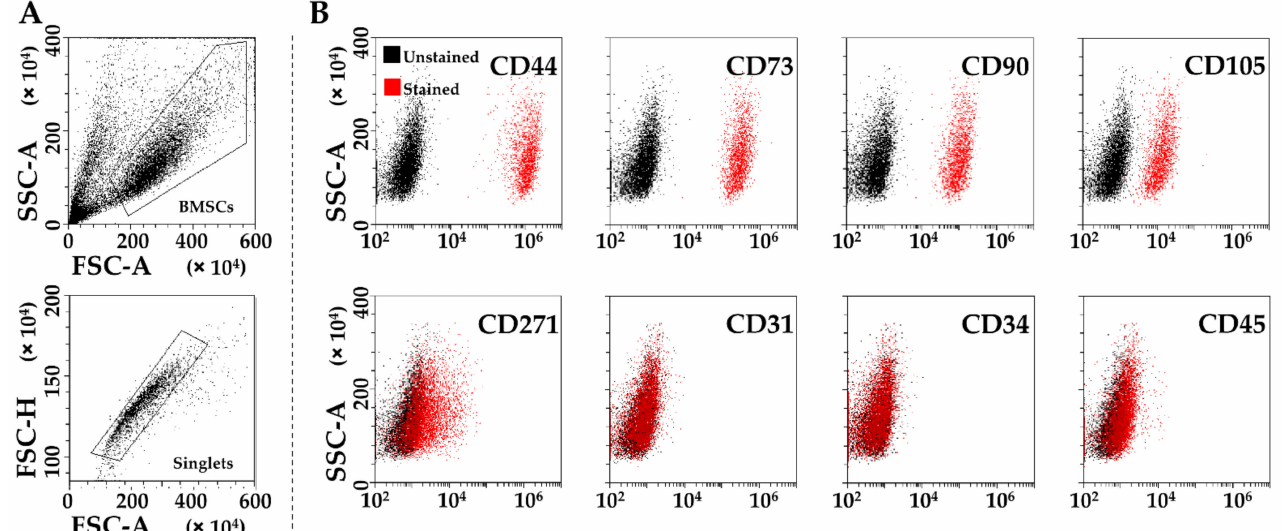
Figure 1. Flow cytometry analysis of SF-treated BMSCs. ( A ), after exclusion of debris (upper panel), single cells were identified (lower panel). ( B ), staining of single cells for general mesenchymal (CD44, CD73, CD90 and CD105, positive), BMSC-specific (CD271, positive) and hemato-endothelial markers (CD31, CD34, and CD45, negative). Representative plots are